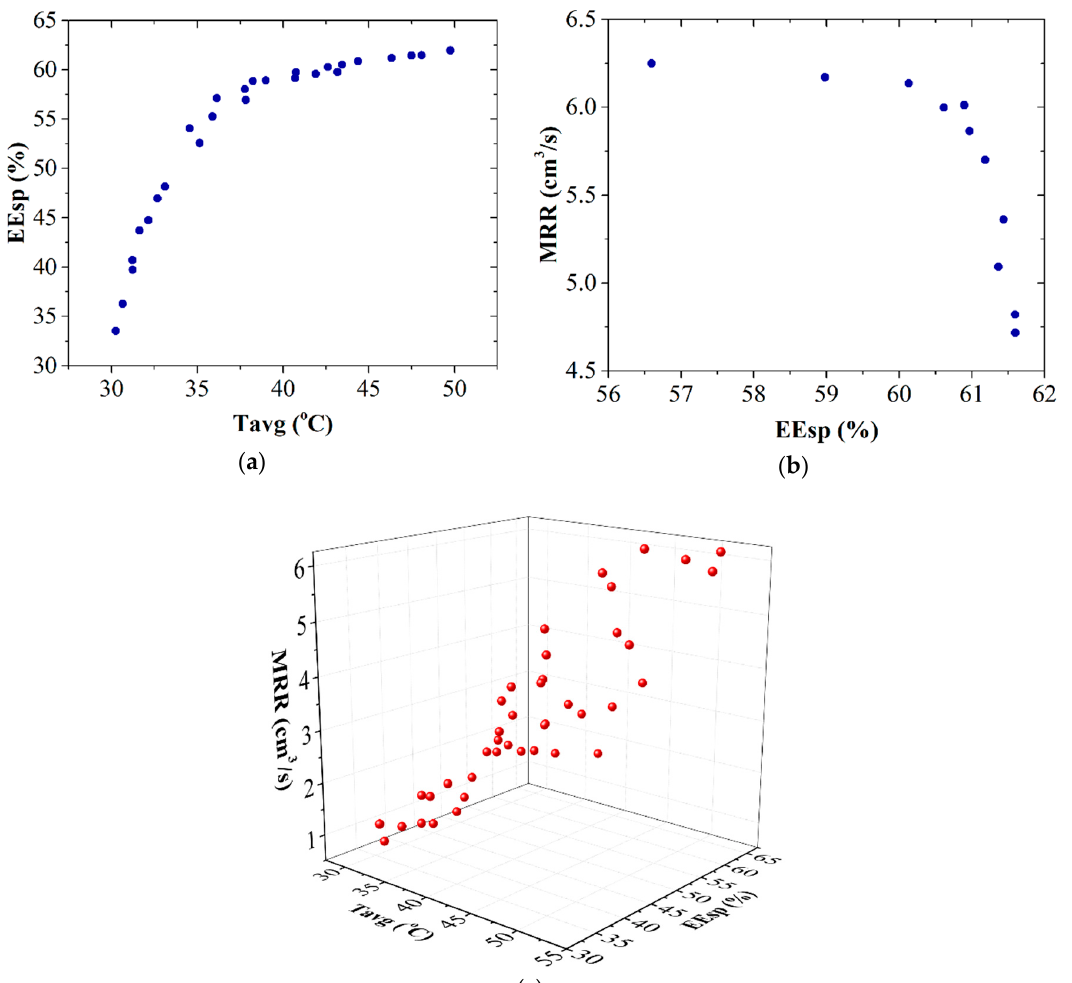
Figure 6. Pareto frontiers under: ( a ) optimization with maximum EE sp and minimum T avg ; ( b ) optimization with maximum MRR and maximum EE sp and ( c ) optimization with maximum EE sp , maximum MRR , and minimum T avg . Table 3. Optimization